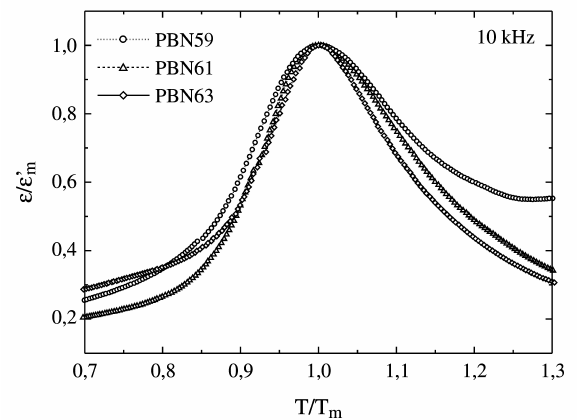
Figura 5. Constante dielétrica normalizada ( ε ’/ ε ’ m ) em função da tem- peratura normalizada (T/T m ) para as amostras Pb 0,59 Ba 0,41 Nb 2 O 6 ,